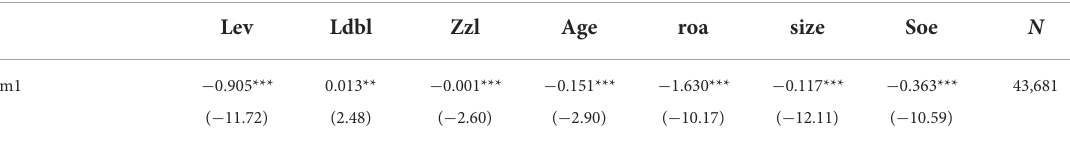
TABLE 8 Propensity score matched